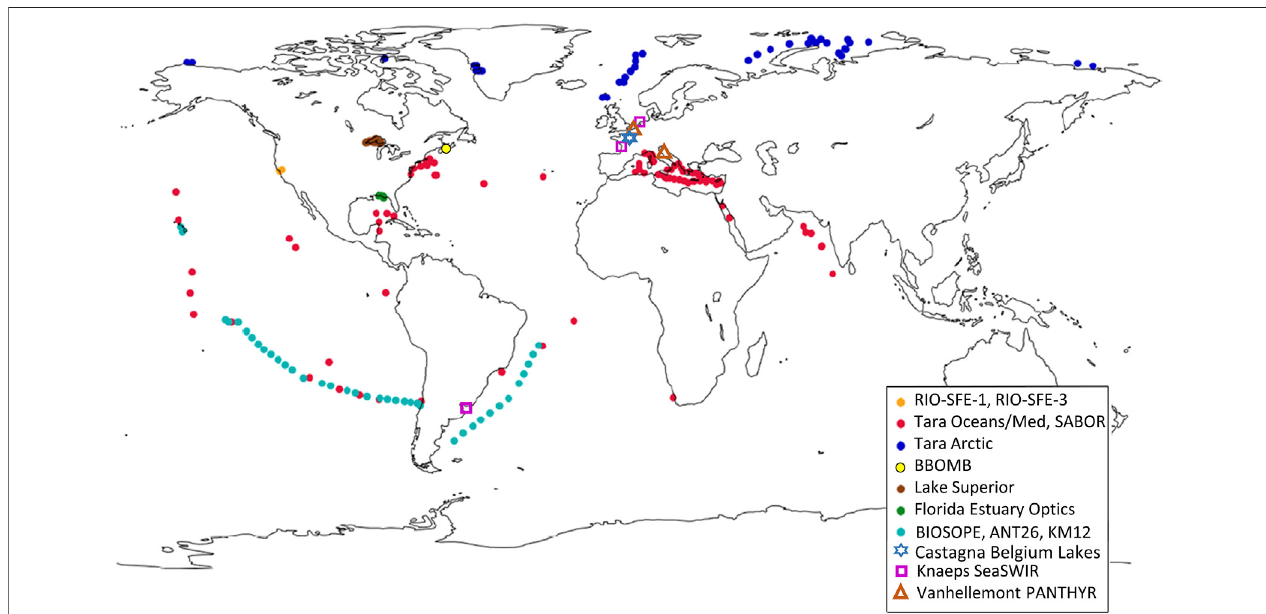
FIGURE 1 | Sampling locations from the global hyperspectral training data (CASCK-P) used to develop the polynomial spanned open ocean, coastal, and inland waters. Adapted from Casey et al. (2020).